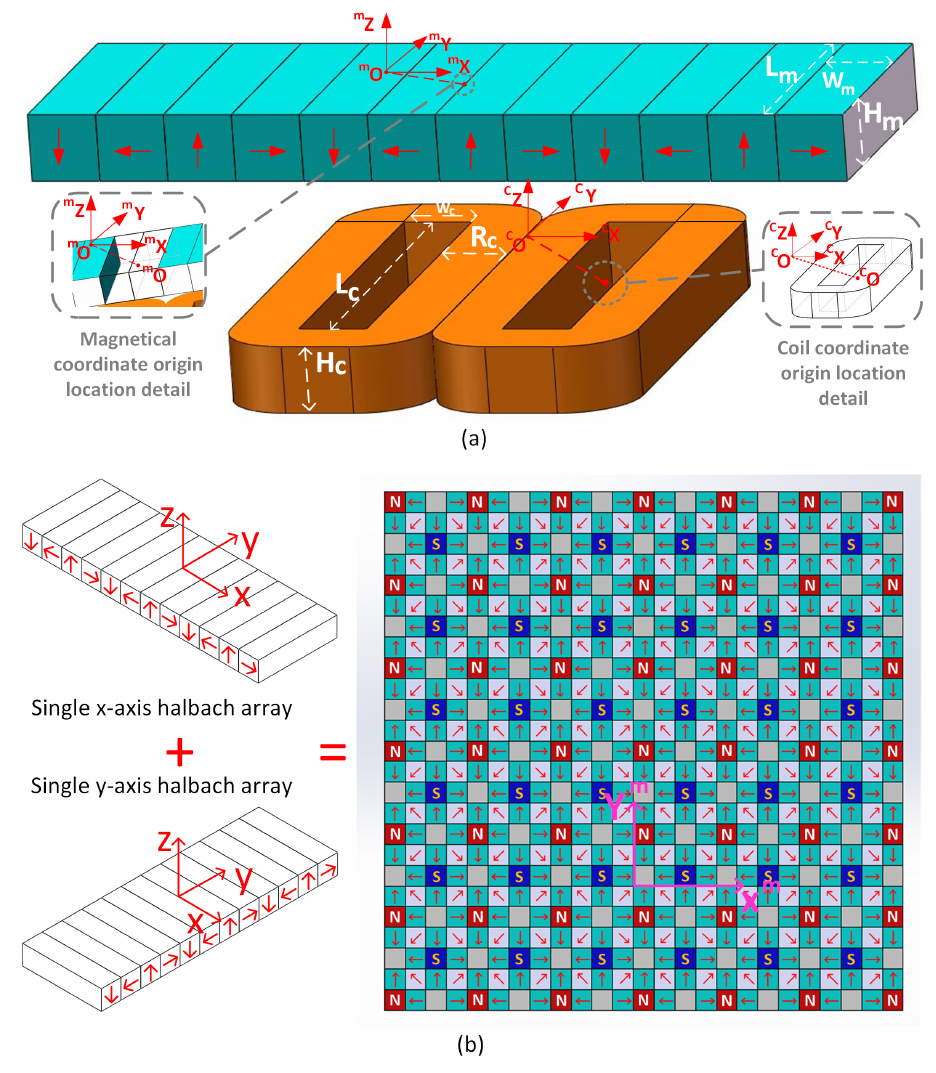
Figure 3. ( a ) 1D linear magnetic unit. ( b ) 2D superimposed magnetic